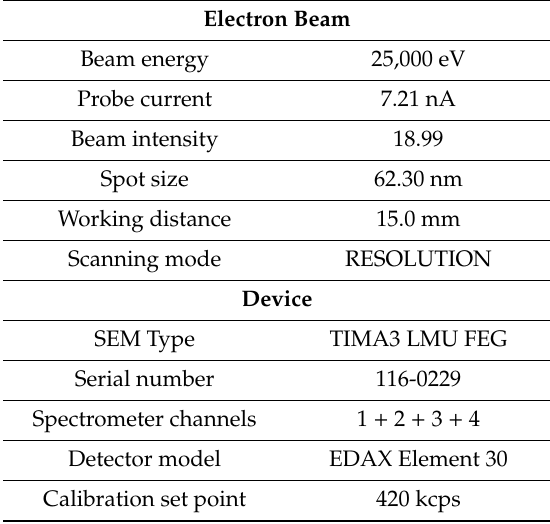
Figure 2. Image of PGE1a polished rock specimen of 25 mm in diameter scanner with TIMA-X (bright circled area of 19.2 mm of diameter) and with LIBS (whole sample). Table 2. TIMA measurement settings used for the PGE rock specimen